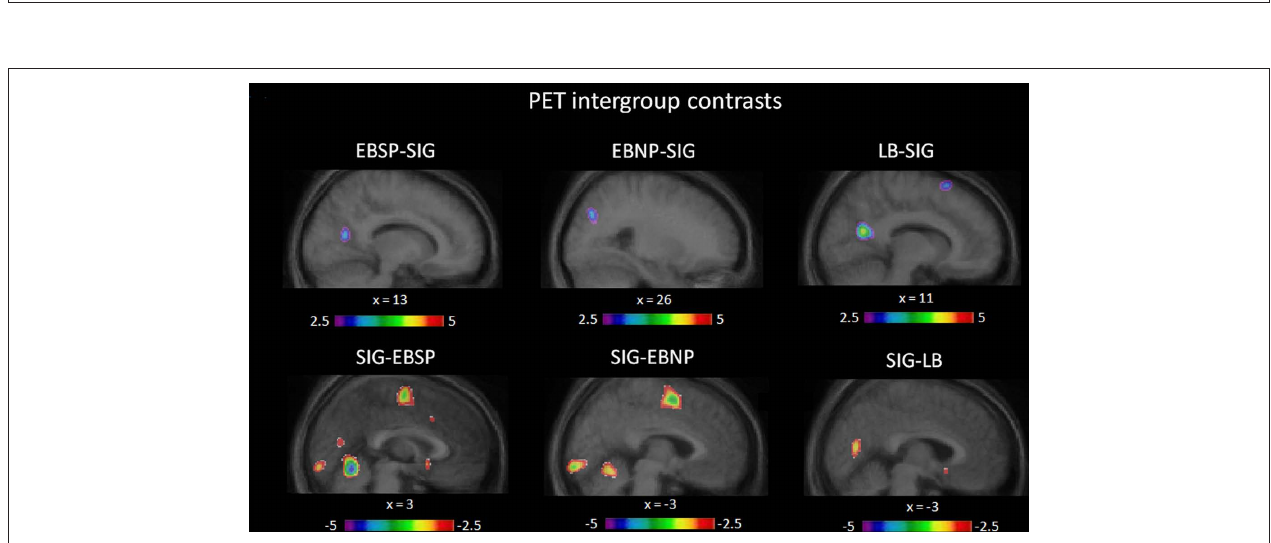
FigurE 3 | Task-related contrasts for each group. Illustrated here are the occipital (de)activation foci generated by the task-related contrasts (task-control baseline) for each group (see Table 1 for complete list of significantly activated brain regions).